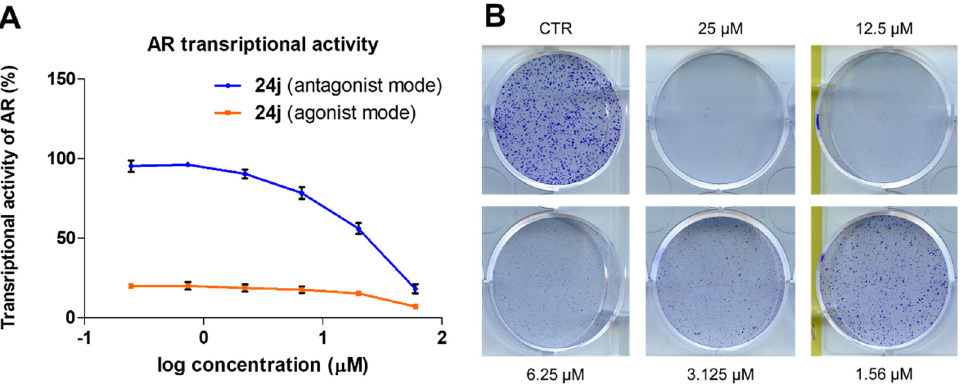
a raw data from all assays and standard errors are included in the Supplementary Materials, Table S1. b Measured in the presence of compound and 1 nM R1881 and normalized to a signal of 1 nM R1881 = 100%, determined in duplicate and repeated twice. c Measured in the presence of compound only, normalized to signal of 1 nM R1881 = 100% and measured in duplicate and repeated twice. d Measured at least in duplicate.